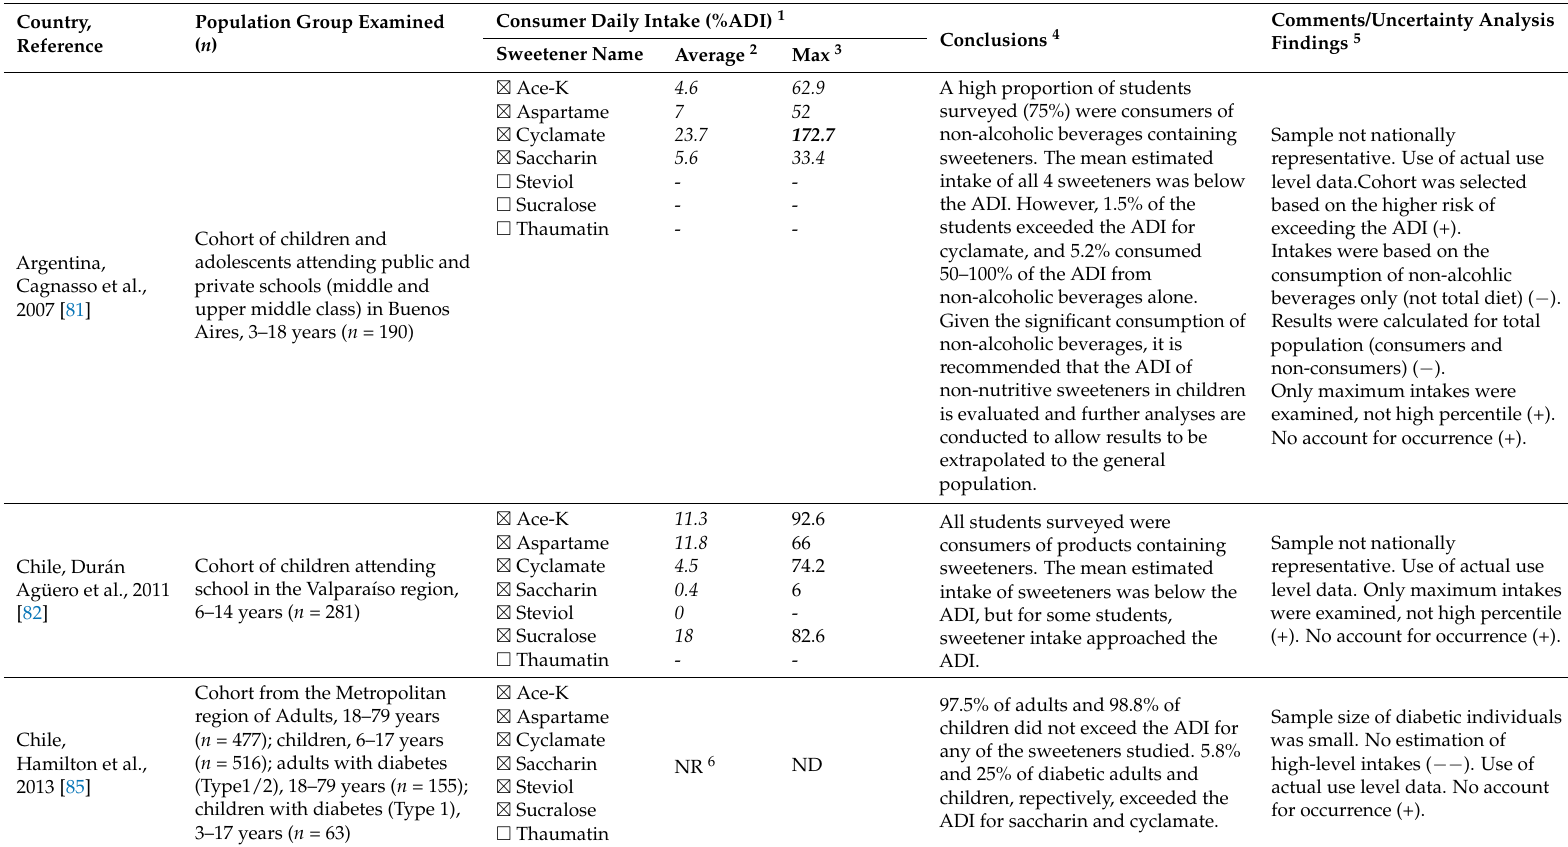
Table 4. Estimated Daily Intakes of for Low-/No-Calorie Sweeteners in Latin